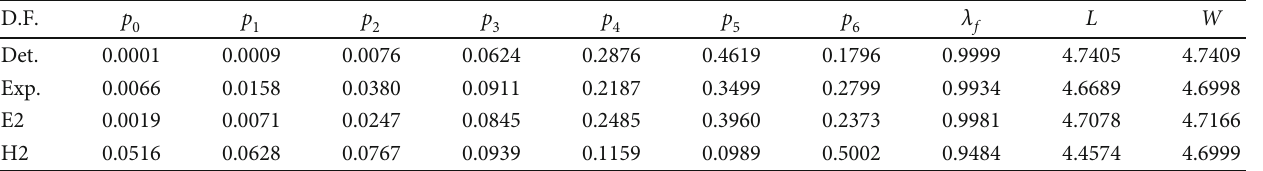
Table 2: The model with M = 6 , N = 3 , Y = 3 , and ρ = 0 : 8 .